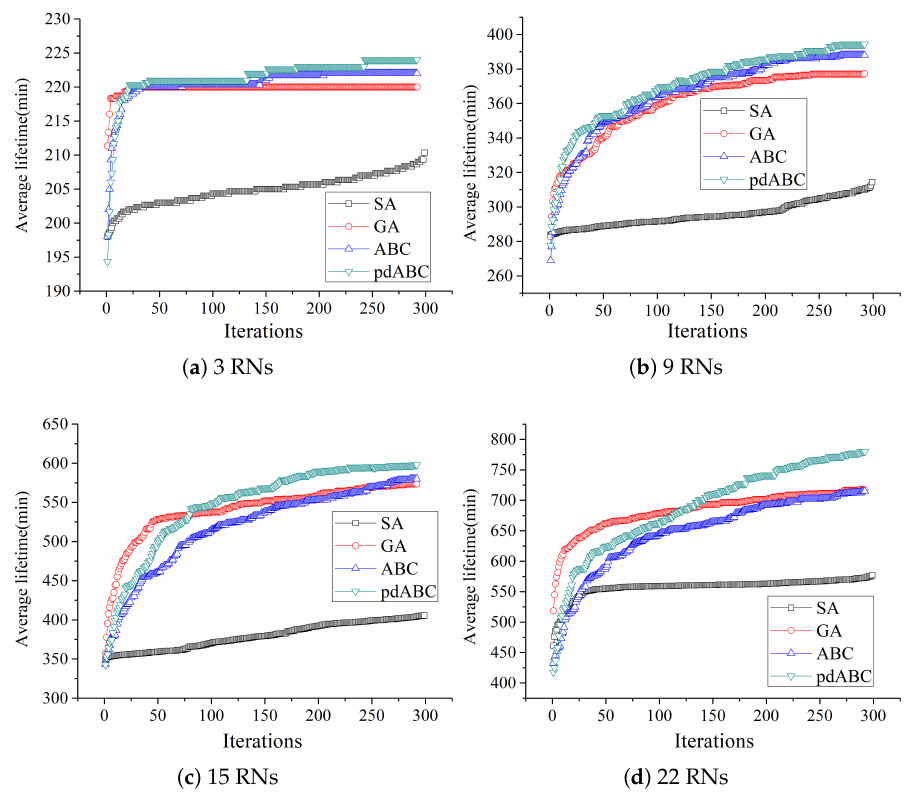
Figure 10. Lifetime optimization trend with different RN numbers in 200 × 200